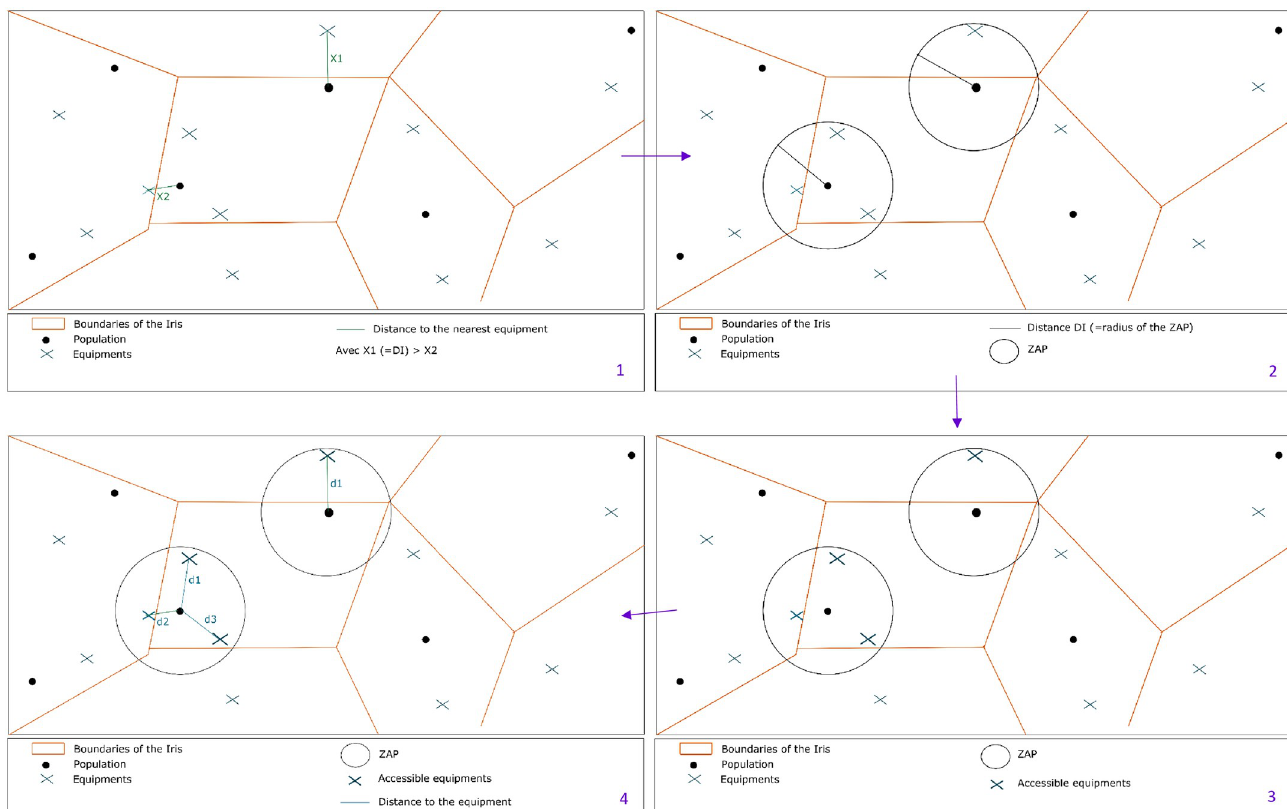
Fig 2. Calculation of potential accessibility